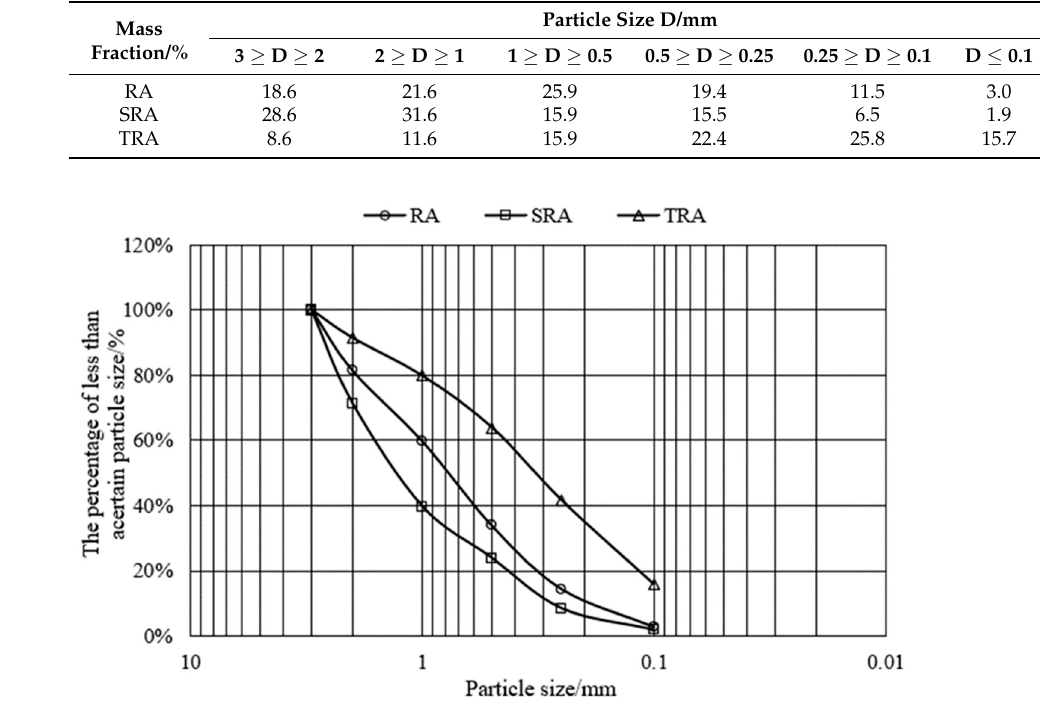
Figure 1. The particle gradation curve of the recycled aggregate.